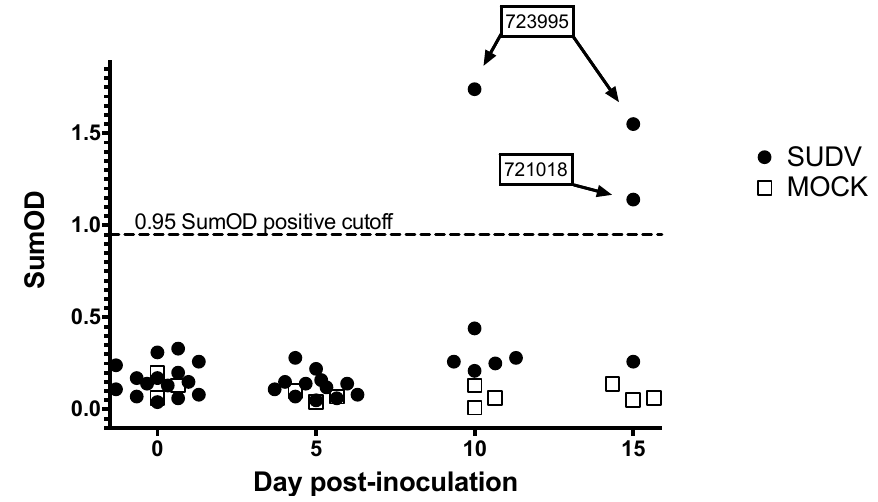
Figure 7. Serology results for Egyptian rousette bats inoculated with Sudan virus in a serial euthanasia study. Results for anti-SUDV IgG measured by enzyme linked immunosorbent assay are shown as adjusted sum optical densities (OD) by day post-inoculation for 15 SUDV inoculated bats (black circles) and 3 mock-inoculated control bats (open squares). Numeric labels represent individual animal identification numbers for two bats that